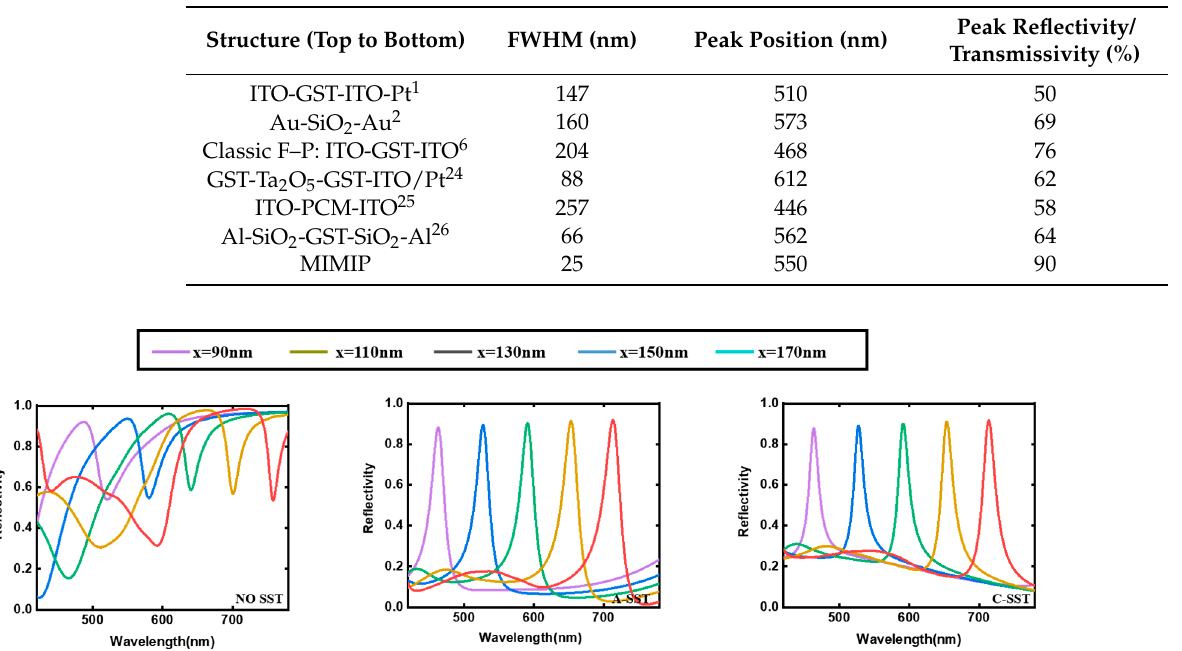
Table 2. Spectral properties of different structures.